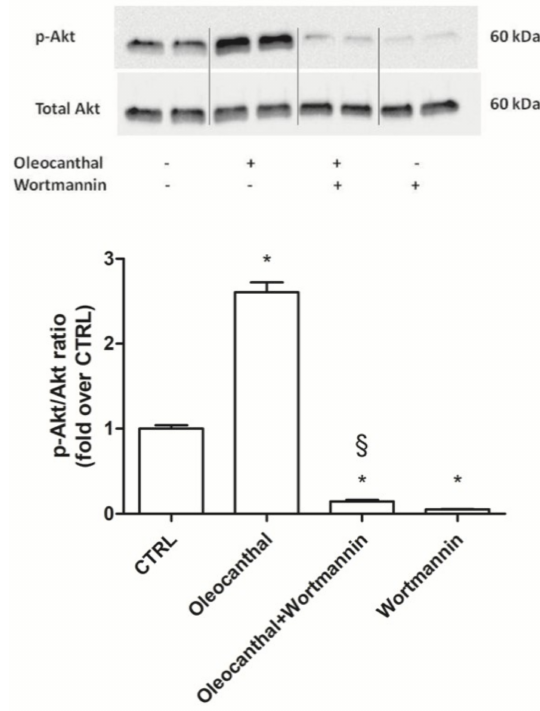
Figure 9. Akt kinase activation following oleocanthal treatment in the presence of PI3K-specific inhibitor. Differentiated SH-SY5Y were exposed to 100 nM wortmannin 1 h before 10 µ M oleocanthal treatment for 1 h. Proteins were separated by SDS-PAGE and immunoblotted for total and phosphorylated form of Akt as reported in Materials and Methods. Each bar represents the mean ± SEM of three independent experiments. Data were analyzed by one-way ANOVA followed by Bonferroni’s test. * p < 0.05 with respect to CTRL; § p < 0.05 with respect to